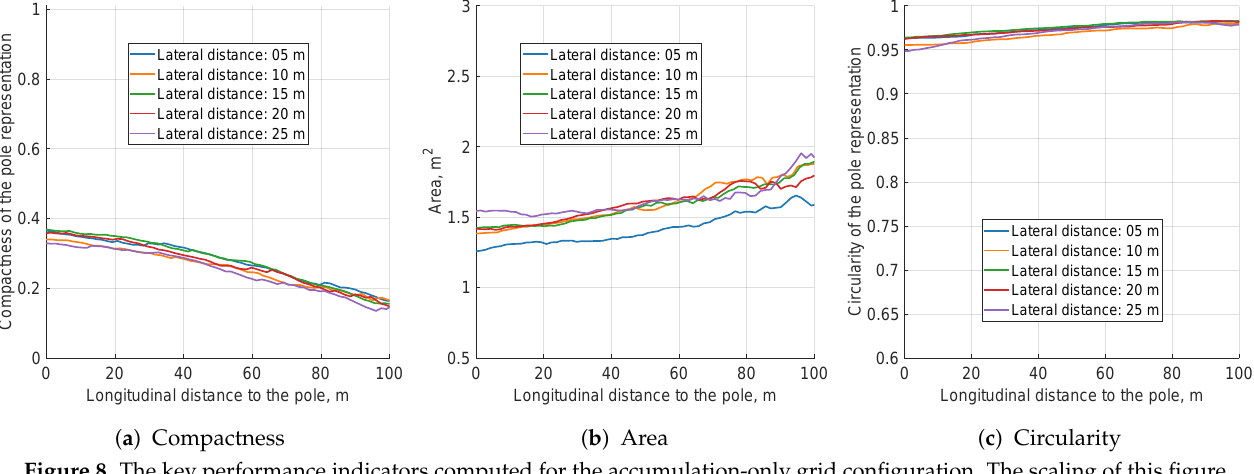
Figure 8. The key performance indicators computed for the accumulation-only grid configuration. The scaling of this figure is the same for all ensuing simulation KPI plots, for easier value